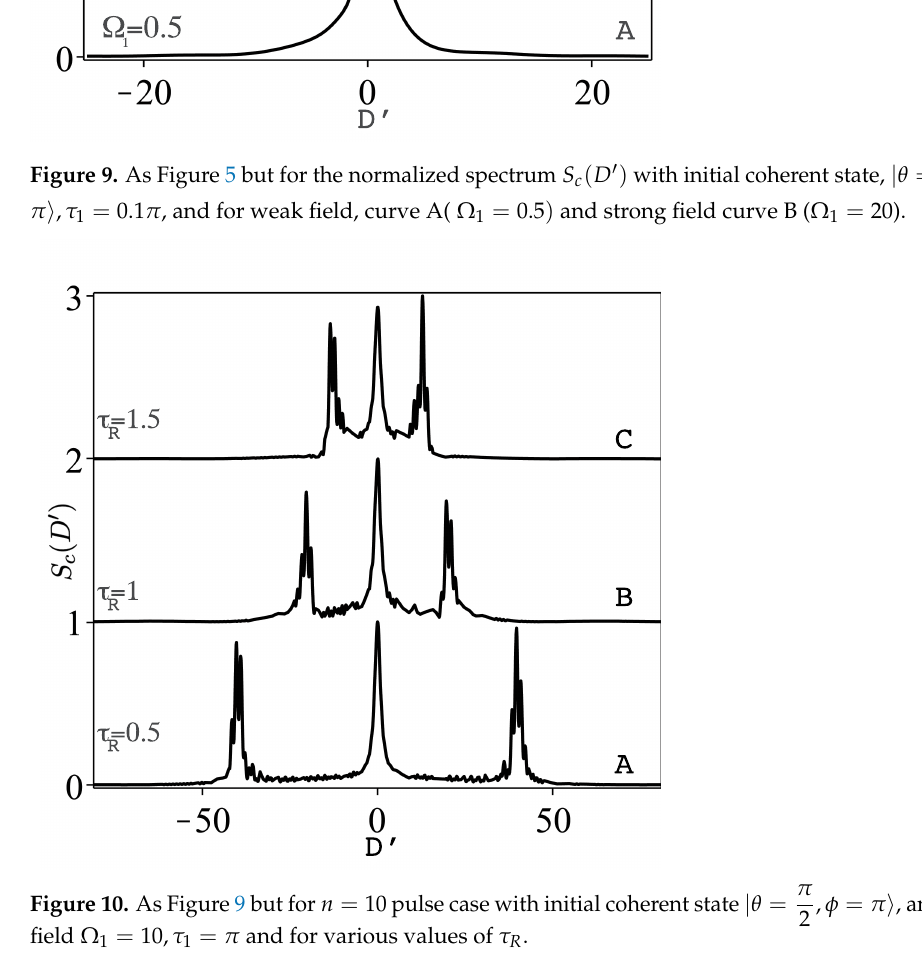
Figure 10. As Figure 9 but for n = 10 pulse case with initial coherent state | θ = field Ω 1 = 10, τ 1 = π and for various values of τ R